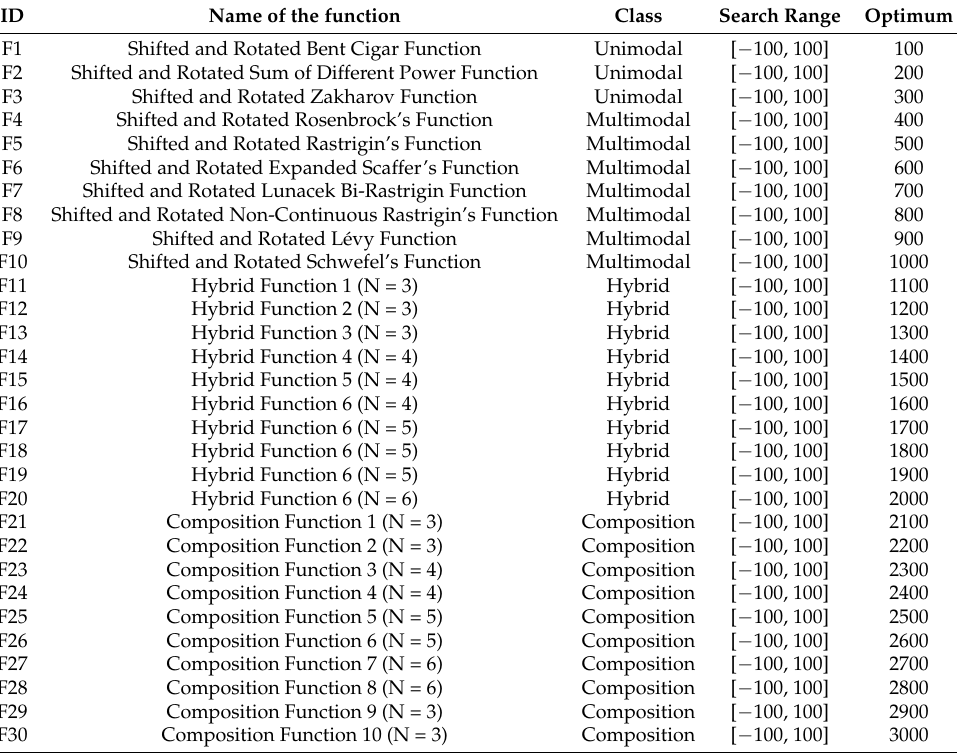
Table 9. CEC 2017 function